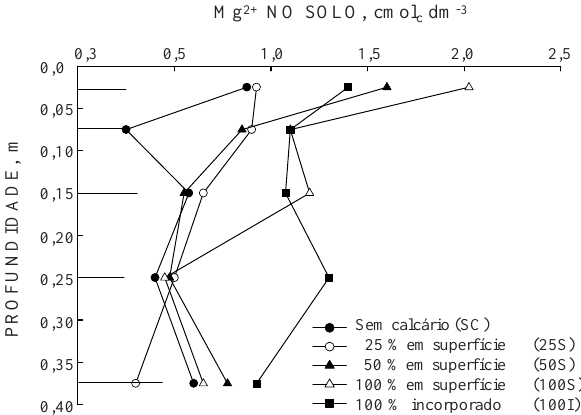
Figura 3. Teores de Ca 2+ em cinco camadas do Argissolo Vermelho distrófico arênico cultivado com milho sob semeadura direta. Barras horizontais representam o DMS.